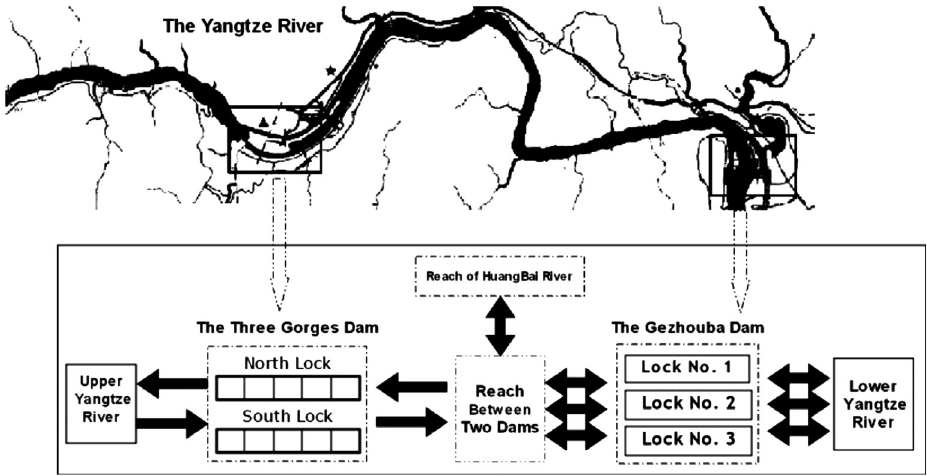
Fig. 1. Navigation system between the Three Gorges Dam and the Gezhouba